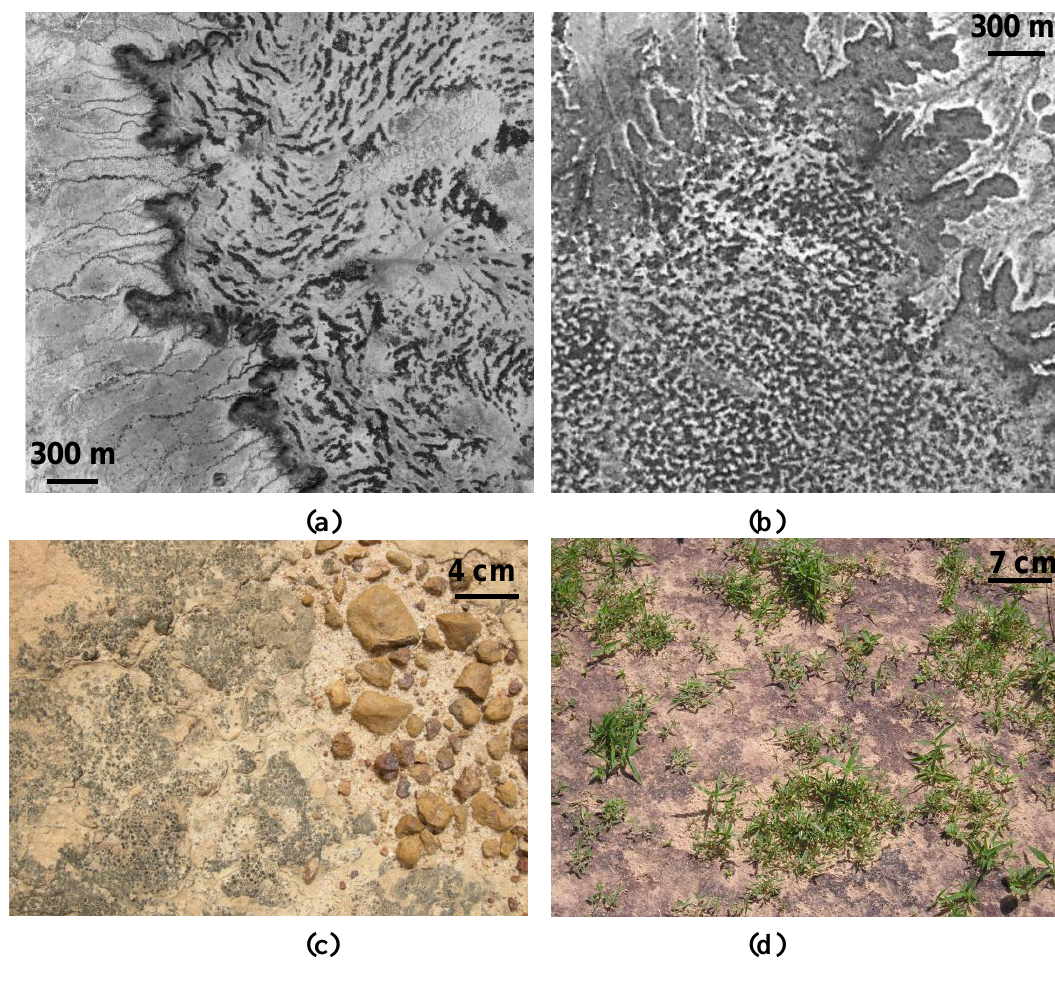
Figure 2. Tiger bush ( Brousse tigrée ) plateau in Banizoumbou (a) , Gapped bush plateau in Tamou (b) , view of biological crusts on lateritic soil of plateaux (c) , view of biological crusts on sandy soil of valley (d) . In (a) and (b), vegetation appears in dark while lighter pixels represent bare soil (optical